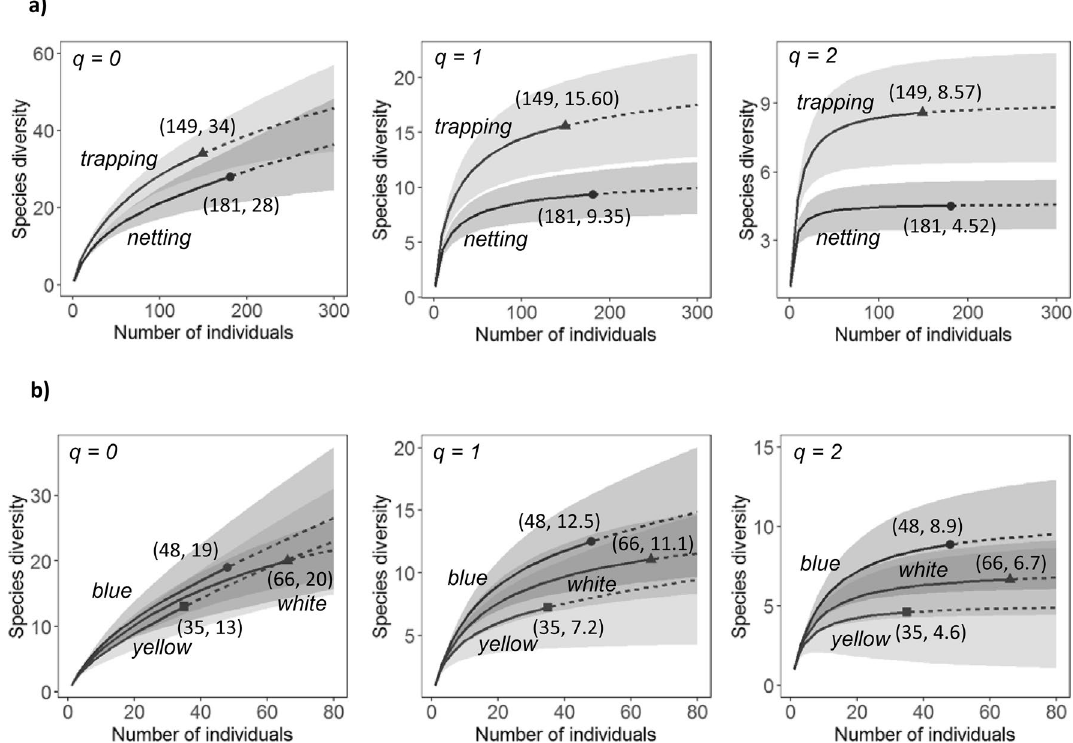
Figure 1. Sample-size-based rarefaction (solid line segment) and extrapolation (dashed line segment) sampling curves for bee diversity. Curves are presented between ( a ) survey methods and ( b ) pan trap colors. Bee diversity of order 0 (q = 0) is species richness, order 1 (q = 1) is Shannon diversity and order 2 (q = 2) is Simpson diversity. The gray-shaded areas represent the 95% confidence intervals and the solid circles, triangles and squares are the reference samples. Sample size and diversity measure are in parentheses. Diversity measures excluded Bombus impatiens